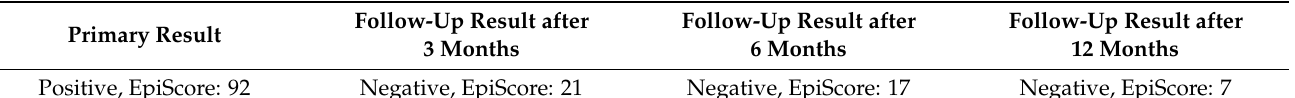
Table 3. Results of monitoring with the Bladder EpiCheck test. The follow-up tests began after the initial six doses of BCG treatment.